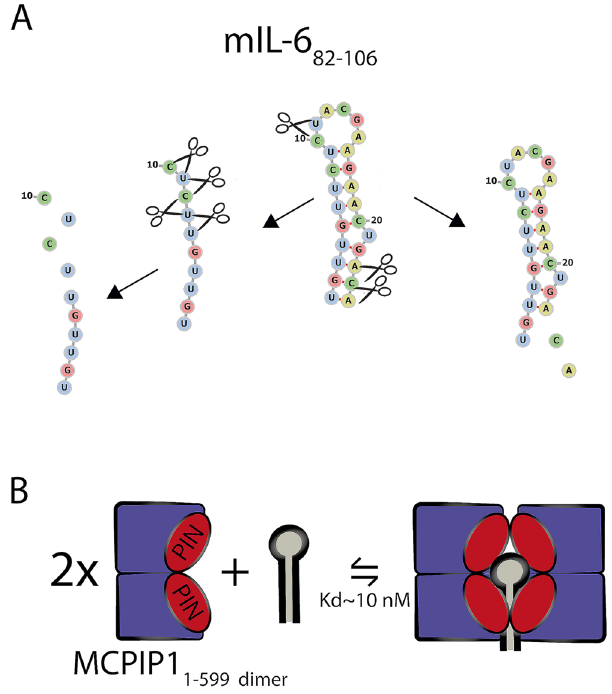
Figure 6. ( A ) Identification of MCPIP1-triggered cleavage sites in the mIL-6 82–106 stem-loop RNA structure. Nt sequences and structures created during MCPIP1-induced cleavage are illustrated. Mapping of the cleavage sites based on the RNase assay results, intermediates and the most significant subsequent degradation products are presented. ( B ) Visualization of the stoichiometry of the MCPIP1 interaction with stem-loops. Schematic cartoon representation of the ternary complex model. The size exclusion chromatography results showed that PIN and PIN-ZF were monomeric and suggest that full-length MCPIP1 most frequently occurs as a dimer in native condition. Stoichiometry of the MCPIP1 - RNA interaction was based on the size exclusion chromatography results and the results from affinity determination assays where the sequential binding model were used. Thus, for full-length MCPIP1, we proposed a sequential binding model: oligo + MCPIP1 Dimer + MCPIP1 dimer 